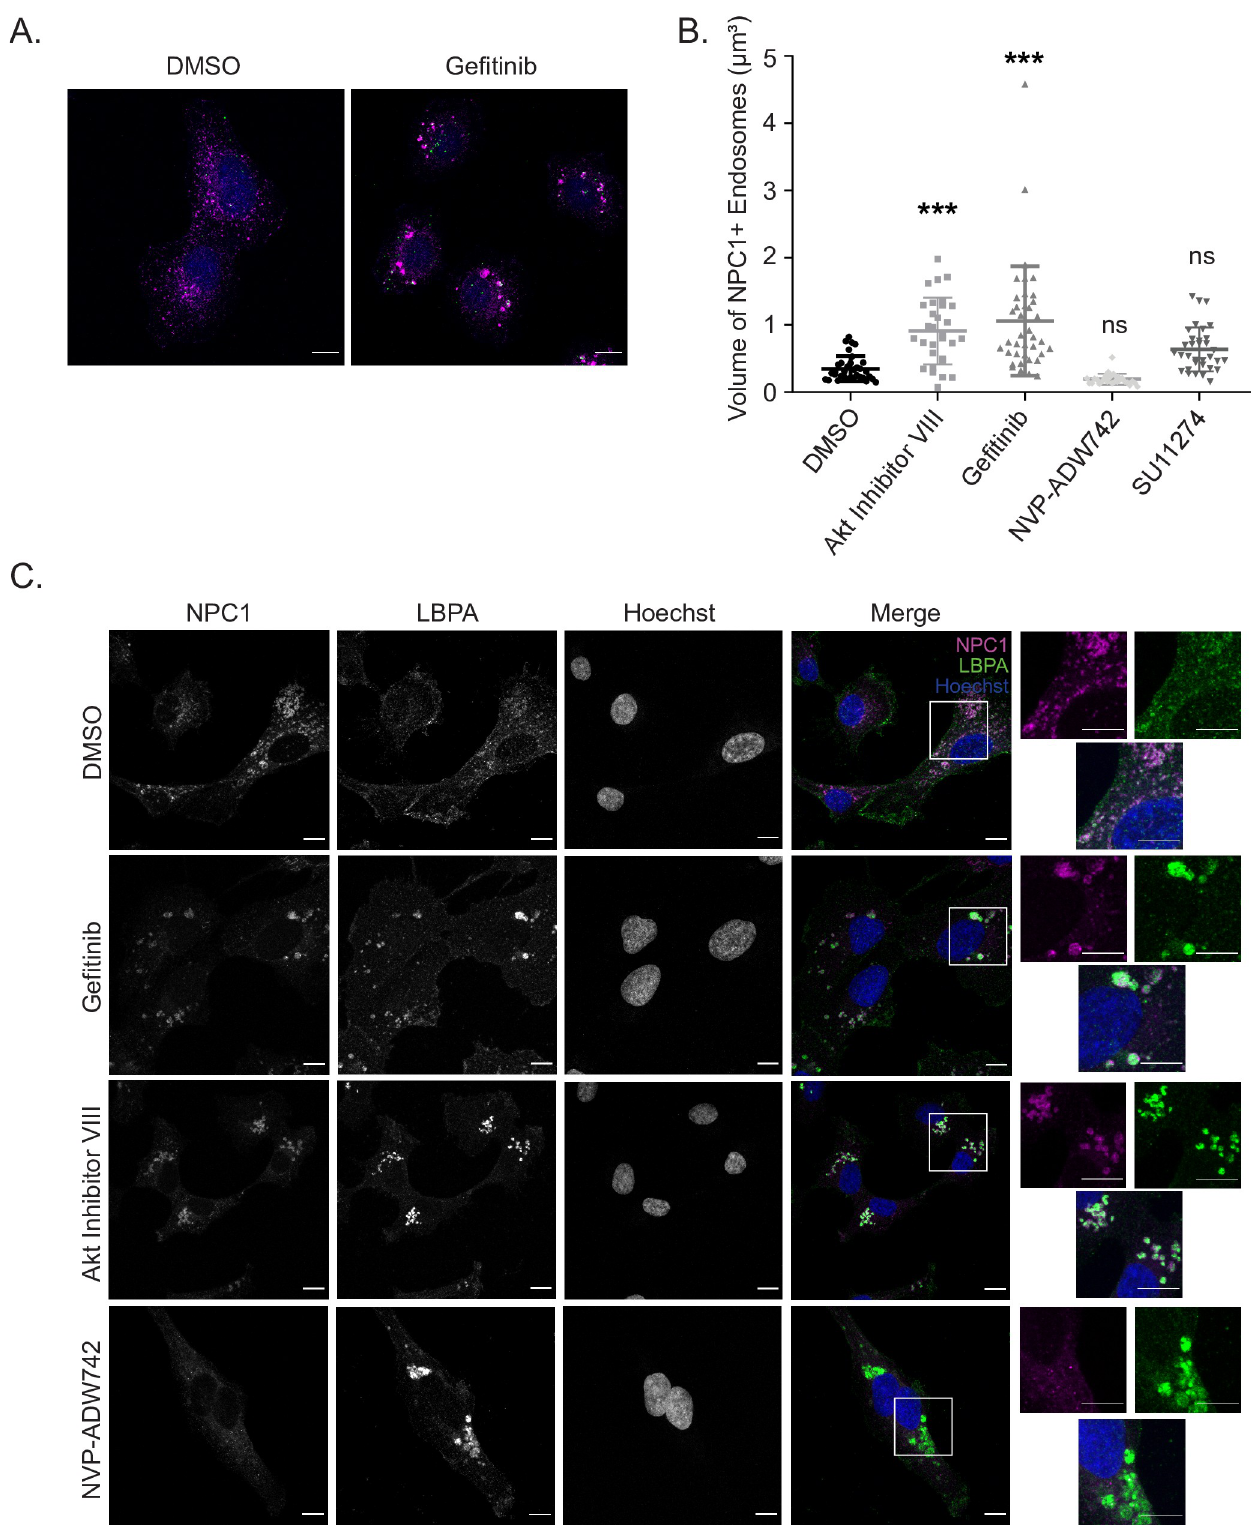
Fig 6. Gefitinib interferes with the biology of NPC1+ compartments. (A) Infection of HT1080 cells pre-treated with vehicle (DMSO, 0.1%) or Gefitinib (5 μ M) with fluorescent VLPs (Green) harboring the fusion deficient EBOV GP F535R for 3 h. 30 min prior to fixation, CMAC cytoplasmic dye (Blue) was